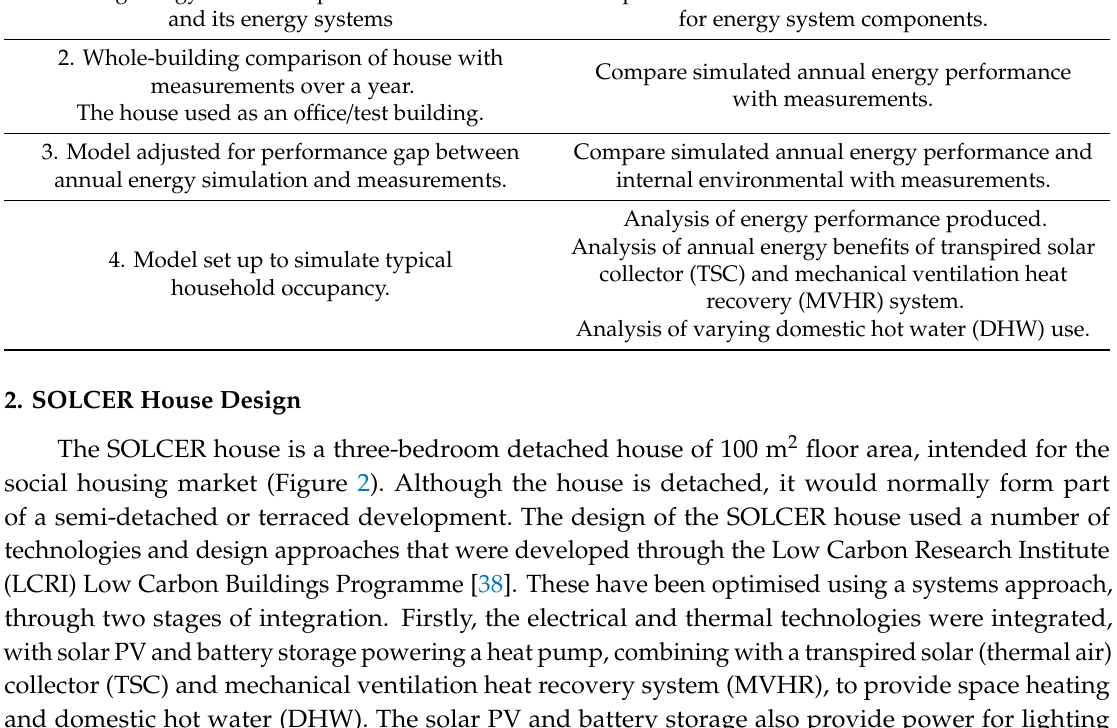
Table 1. Method stages and main outcomes.